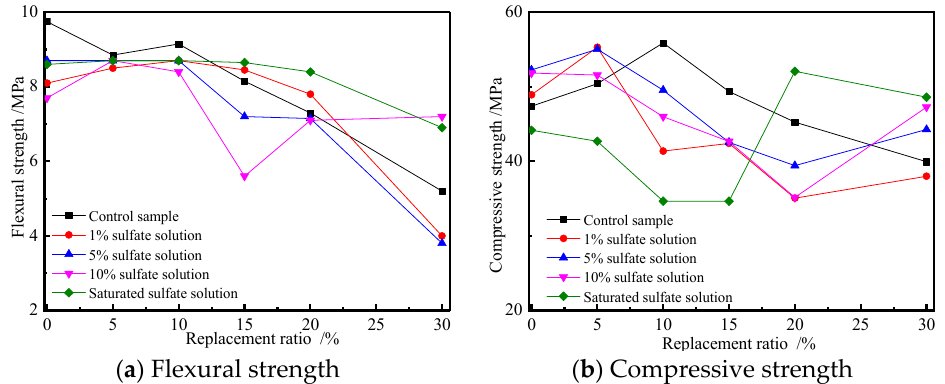
Figure 1. Variation curves of mortar strength with replacement ratios of cement by fly ash exposed to sulfate solution for 2 months.